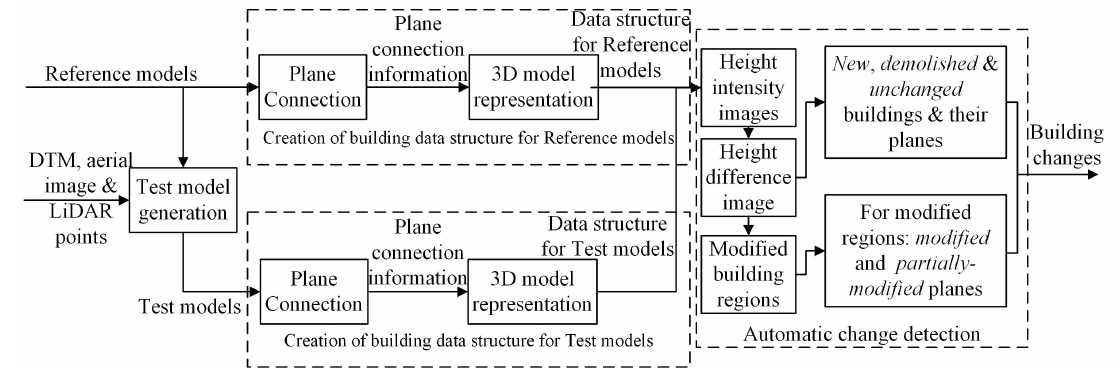
Figure 8. The flow diagram of the proposed building change detection